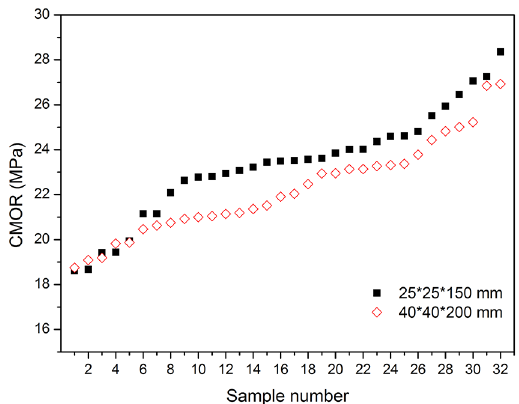
Figure 2. Distribution of cold modulus of rupture for high alumina bricks